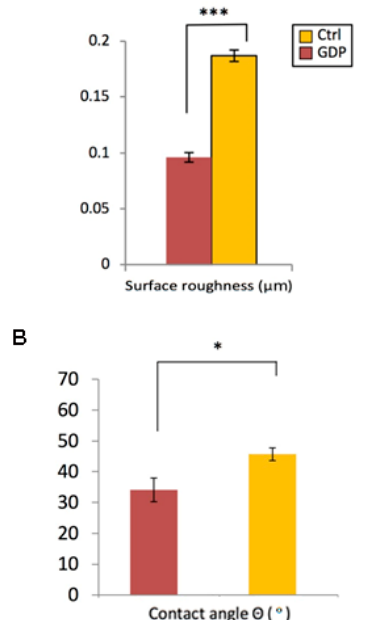
Figure 3. ( A ) The GDP treatment effect on the surface’s roughness (Ra) of Zr discs. The GDP-treated discs showed the lowest roughness, indicating a smoother surface. *** p < 0.001. ( B ) The contact angle evaluation for each surface treatment. The index of surface wettability was the contact angle; thus, the formation of the angle by a water droplet refers to the parameter, θ , at the sample surface. Quantitative analysis indicated that the surface wettability of GDP-treated Zr discs was improved compared with the control samples. * p < 0.05.